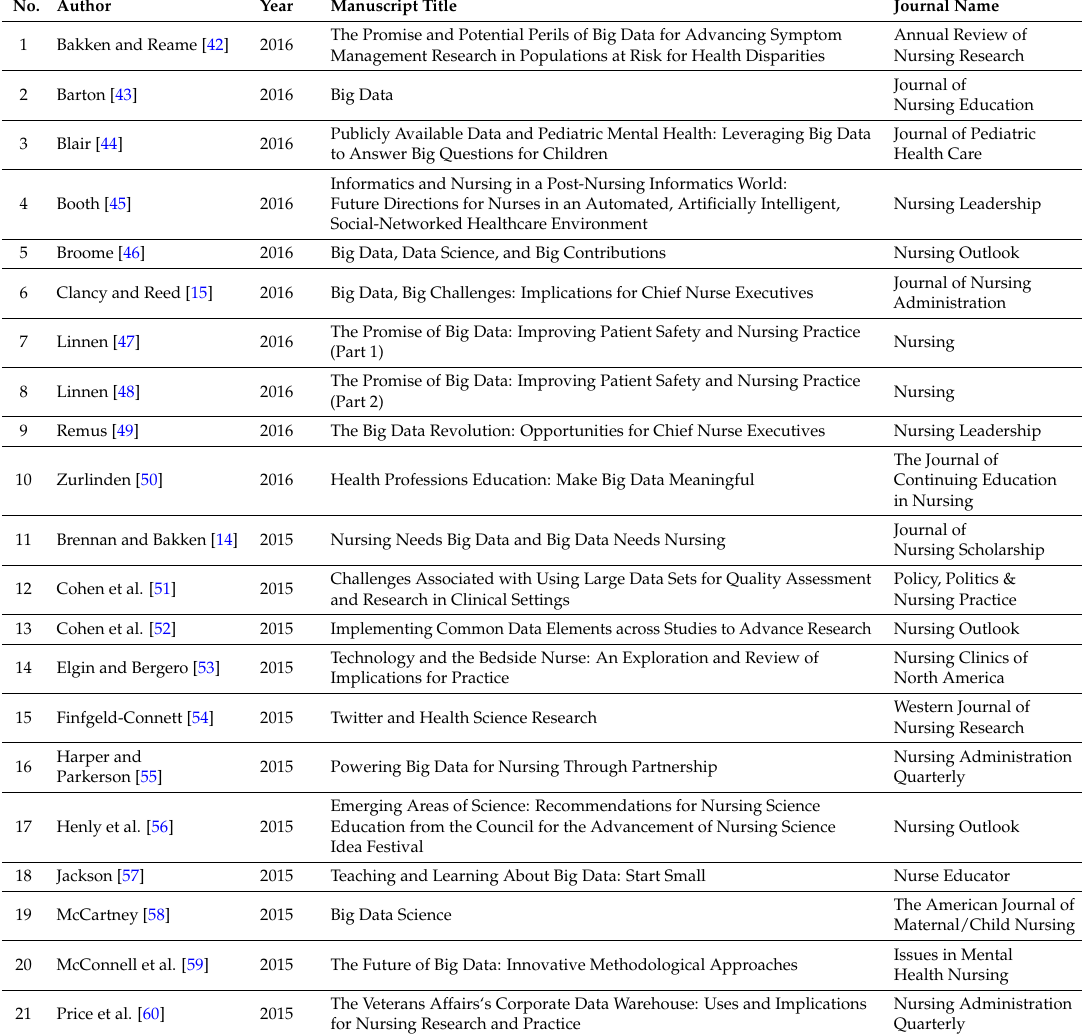
Table A1. The 38 Big Data related publications in PubMed Nursing